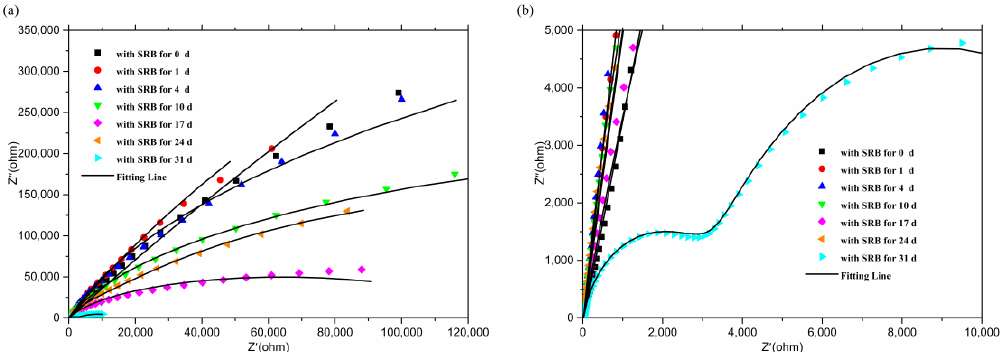
Figure 5. ( a ) The fitting result of each equivalent circuit and ( b ) the enlarged view of the fitting result of each equivalent circuit.